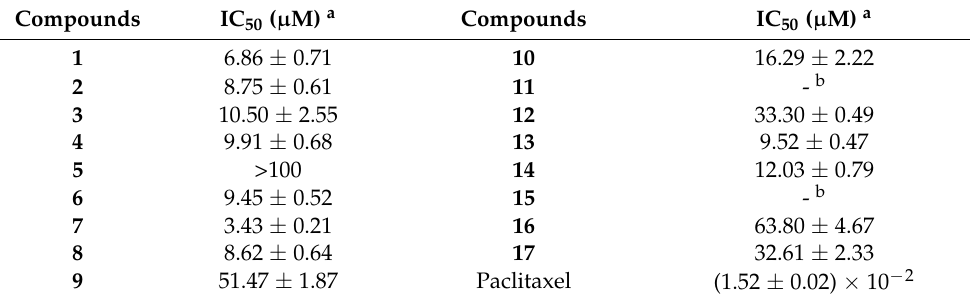
Table 2. Cytotoxicity of phenanthrenes 1 – 17 against A549 cells.